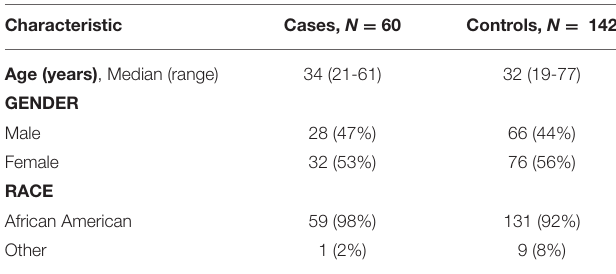
TABLE 1 | Demographic characteristics of the analyzed case ( n = 60) and control ( n = 142) subjects.